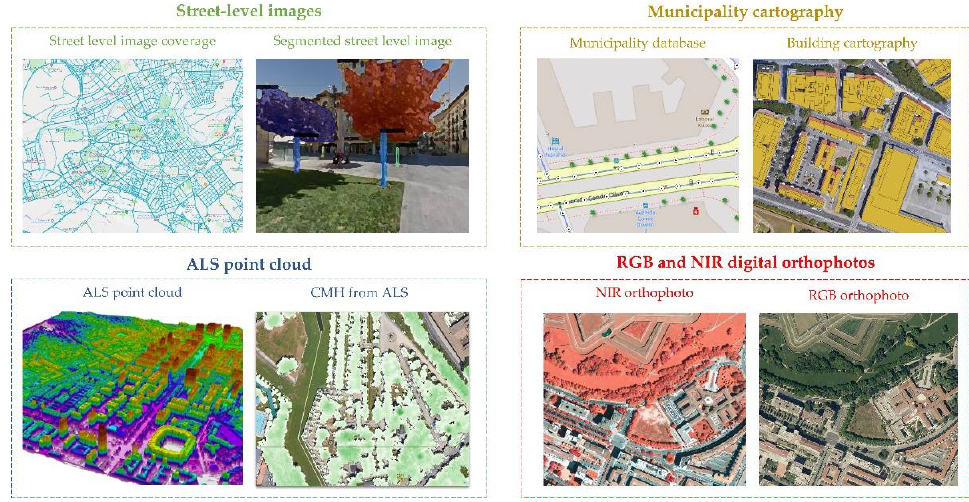
Figure 2. Remote data used in this